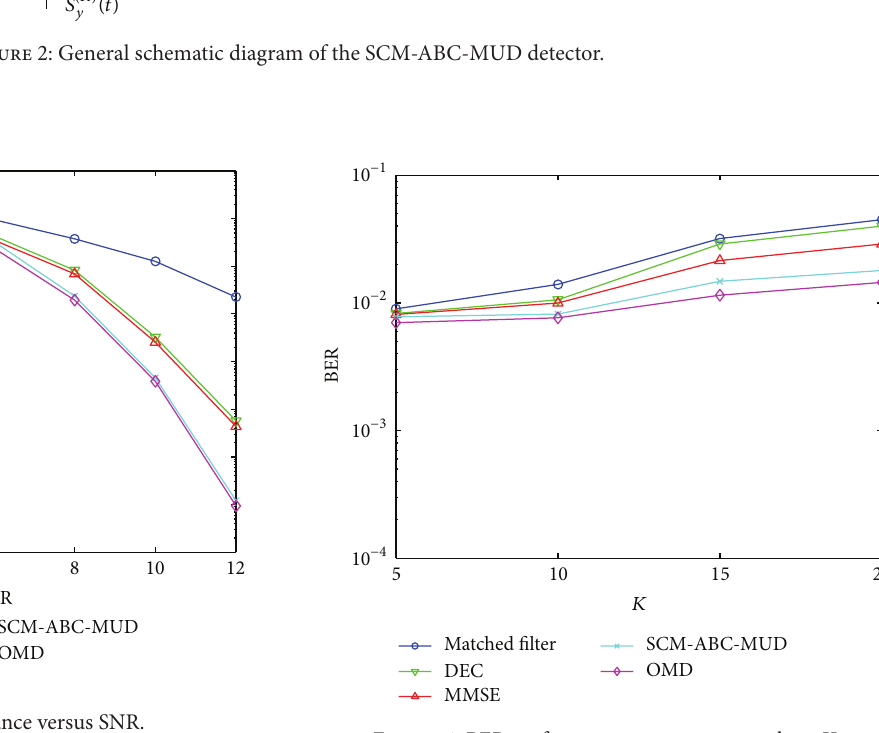
Figure 4: BER performance versus user numbers 𝐾